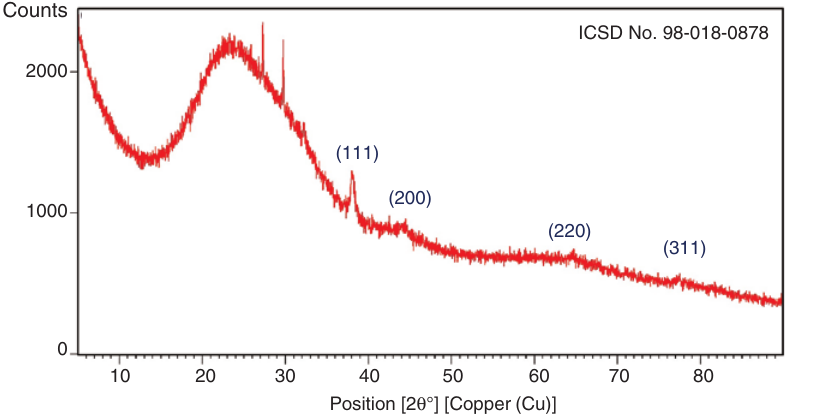
Figure 6: X-ray diffraction (XRD) spectra of as-synthesized silver nanoparticles (AgNps) using Shora fruit extract and sunlight.